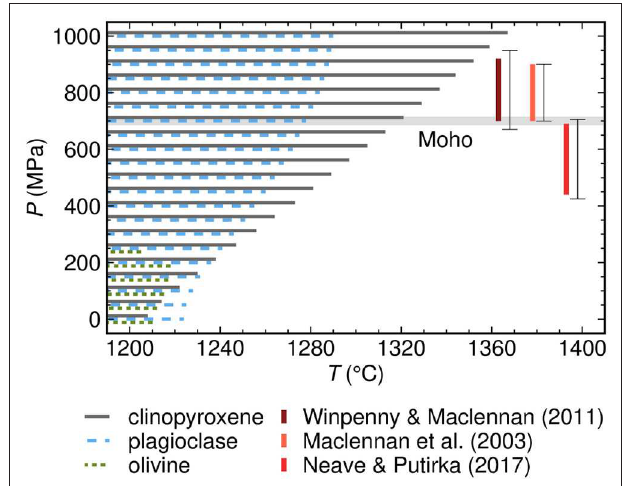
FIGURE 1 | Mineral stabilities in the Borgarhraun lava flow from North Iceland calculated with the MELTS algorithm (Ghiorso and Sack, 1995; Smith and Asimow, 2005 ). Calculations were performed using the matrix glass composition reported by Sigurdsson et al. (2000), and highlight the strong pressure dependence of clinopyroxene stability. Horizontal lines indicate the temperature ranges over which clinopyroxene, plagioclase and olivine are stable during isobaric fractional crystallization at different pressures. The depth of the seismic Moho from Staples et al. (1997) is shown alongside petrological estimates of pre-eruptive magma storage pressures ( Maclennan et al., 2003b; Winpenny and Maclennan, 2011; Neave and Putirka, 2017). Vertical colored bars show 1 σ uncertainties in pressure estimates; vertical error bars show model uncertainties expressed as standard errors of estimate (SEEs).